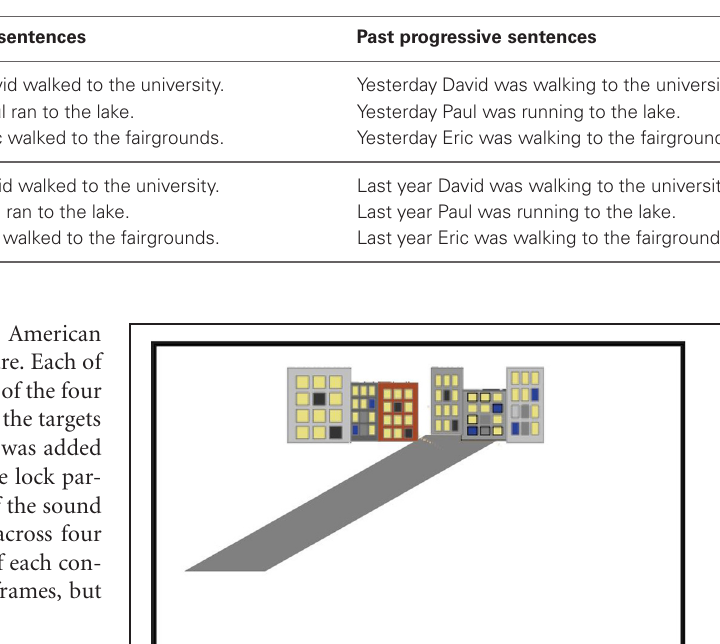
Table 1 | Examples of target verbal stimuli that accompanied visual scenes.